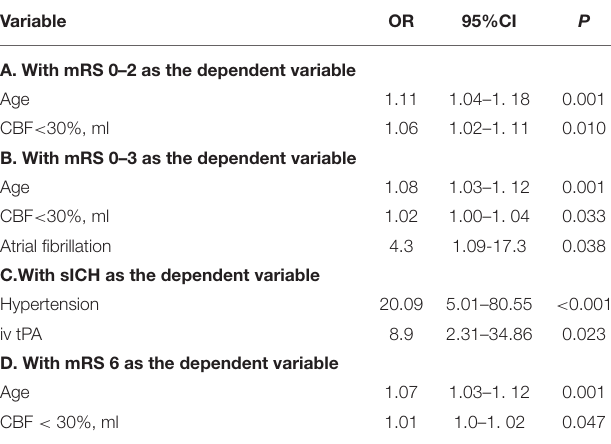
TABLE 2 | Multivariate logistic regression analysis for